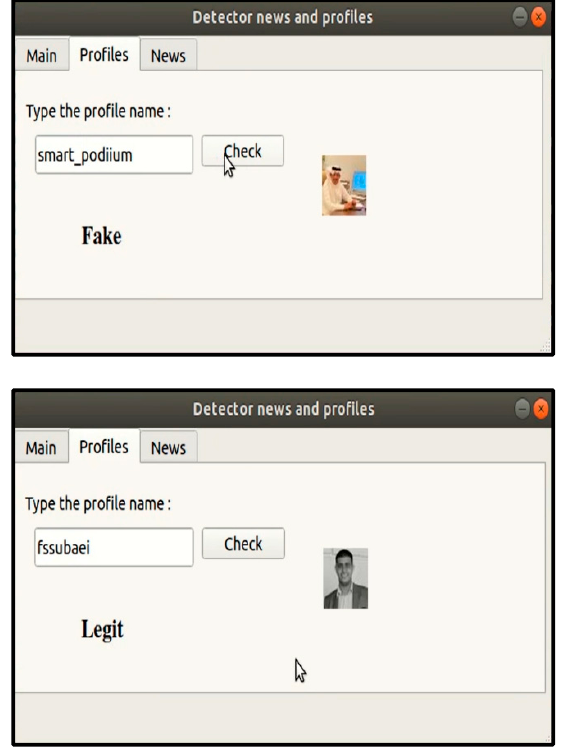
Figure 4. The result of detecting the status of Twitter account as either fake or legitimate.